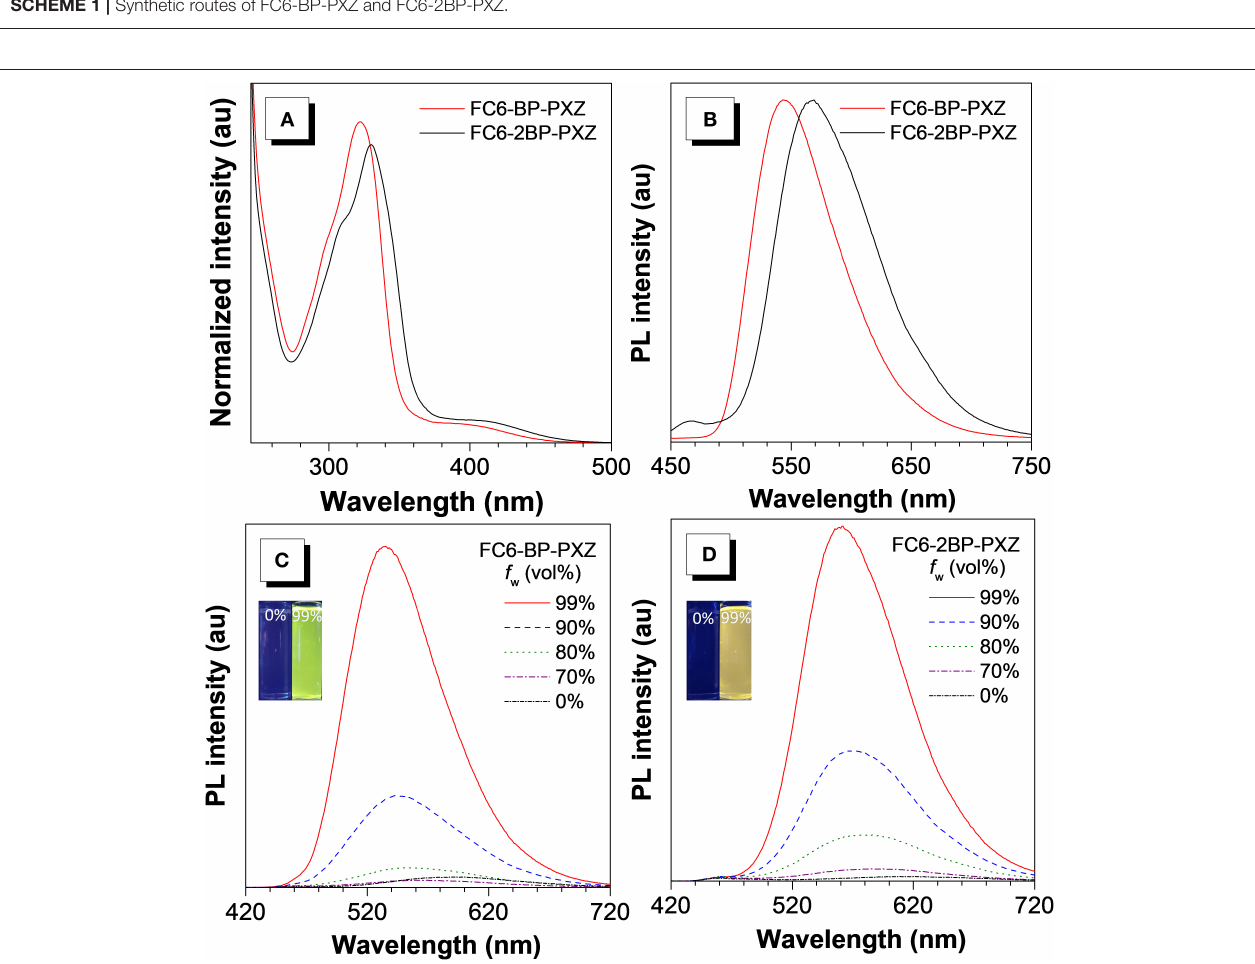
FIGURE 1 | (A) Absorption spectra in THF solutions (10 − 5 M) and (B) PL spectra in neat films of FC6-BP-PXZ and FC6-2BP-PXZ. PL spectra of (C) FC6-BP-PXZ and (D) FC6-2BP-PXZ in THF-water mixtures with different water fractions ( f w